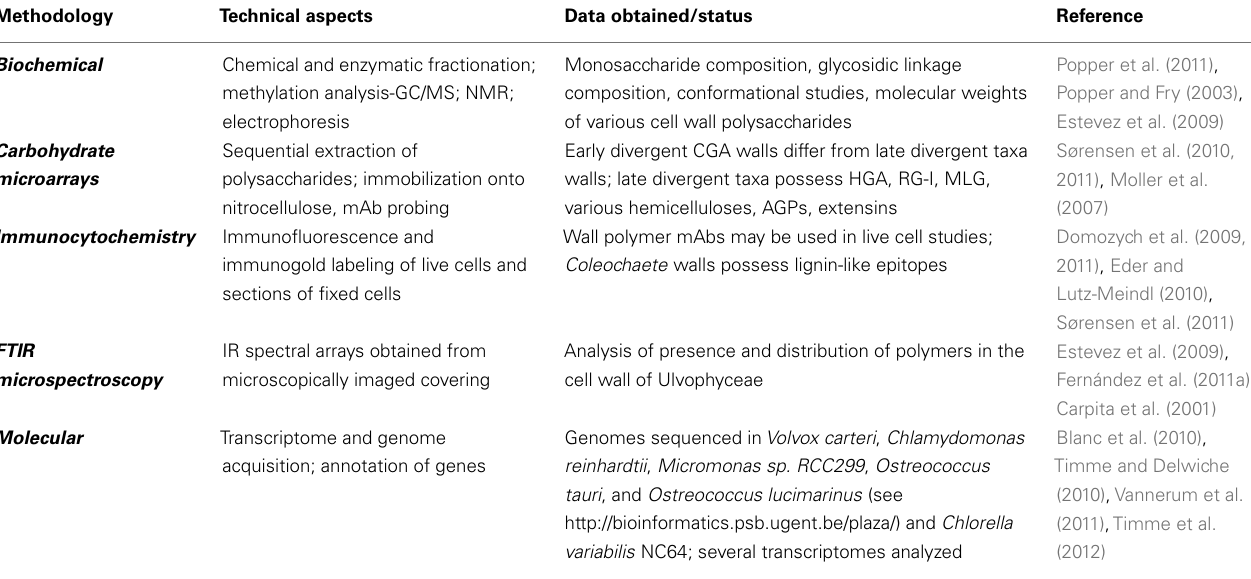
Table 1 | Major methodologies used today in the study of green algal